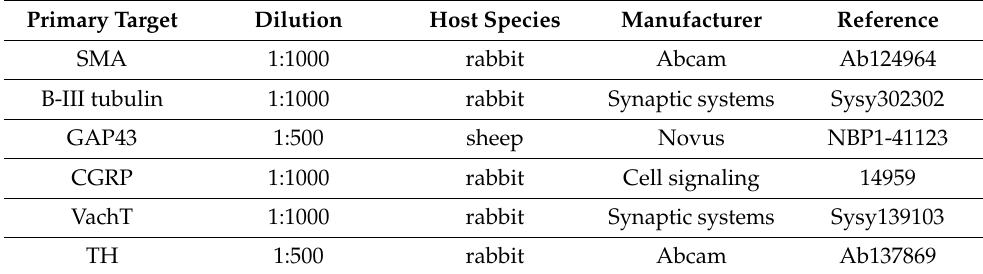
Table 2. This table depicts the list of primary antibodies used in the present study. The source, host species, and dilution are